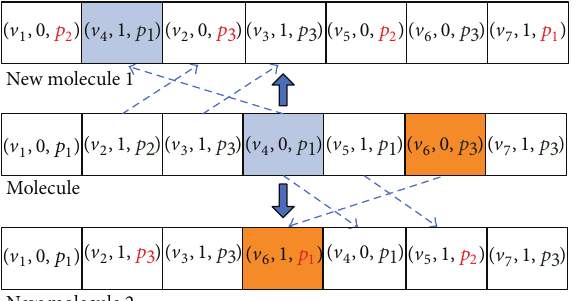
Figure 6: Illustration of molecular structure change for decompo- sition.